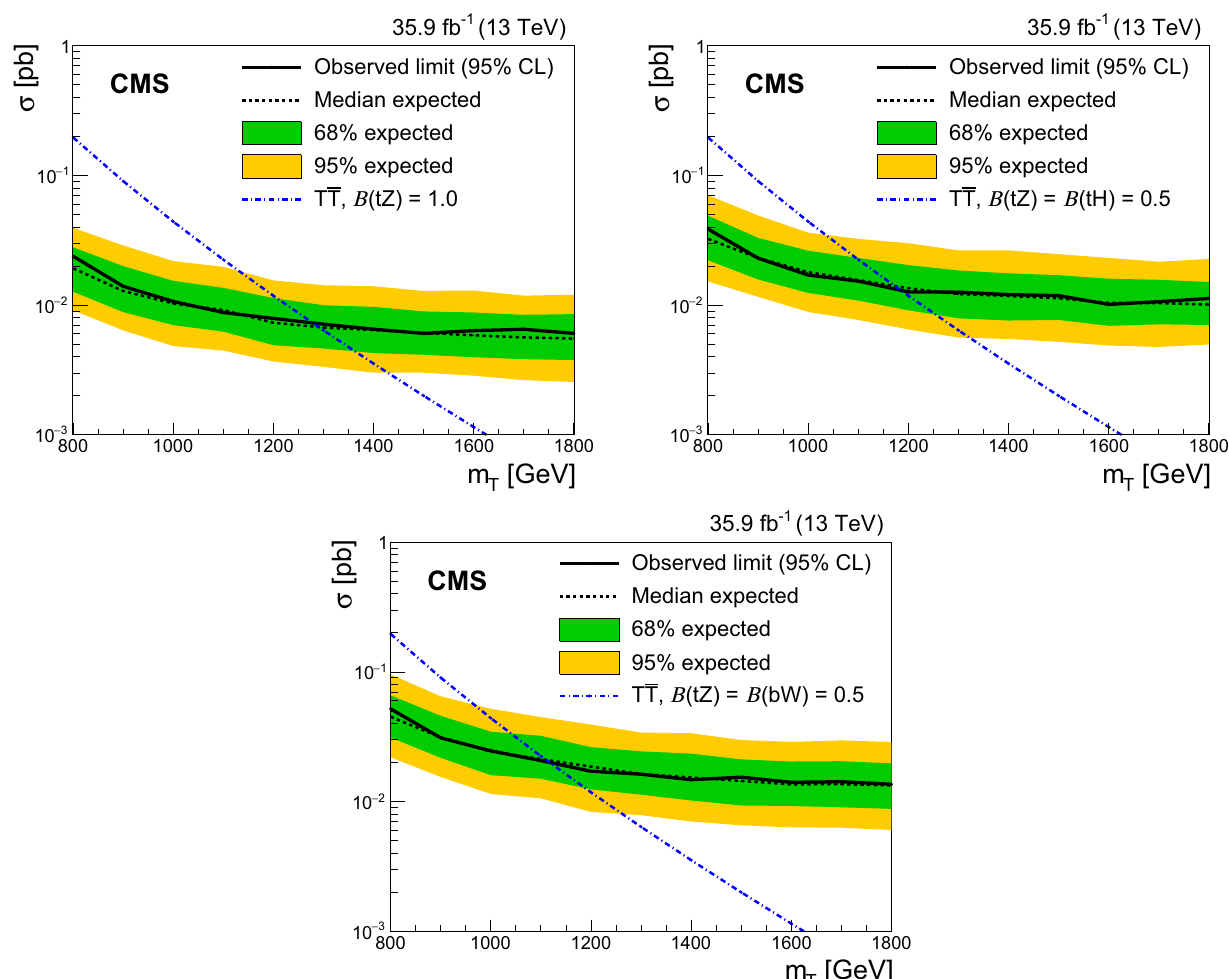
Fig. 4 The observed (solid line) and expected (dashed line) 95% CL upper limits on the TT cross section as a function of the T quark mass assuming(upperleft) B ( T → tZ ) = 100%,(upperright) B ( T → tZ ) = B ( T → tH ) = 50%, and (lower) B ( T → tZ ) = B ( T → bW ) = 50%.